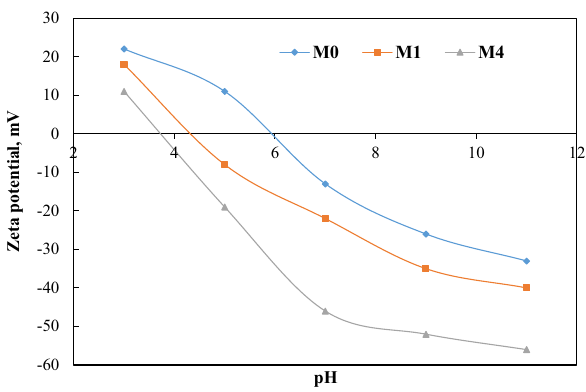
Fig. 8 The zeta potential of the fabricated